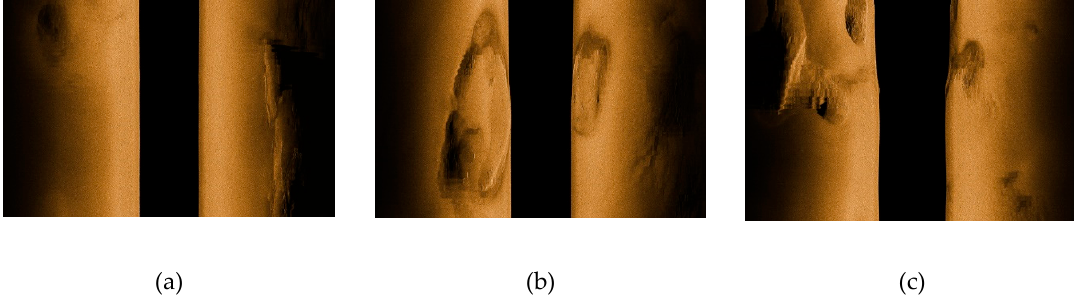
Figure 11. Original side-scan sonar images: (a) a large area of black area, (b) an image with no black area and more texture, and (c) image with black areas, textures, and hills.